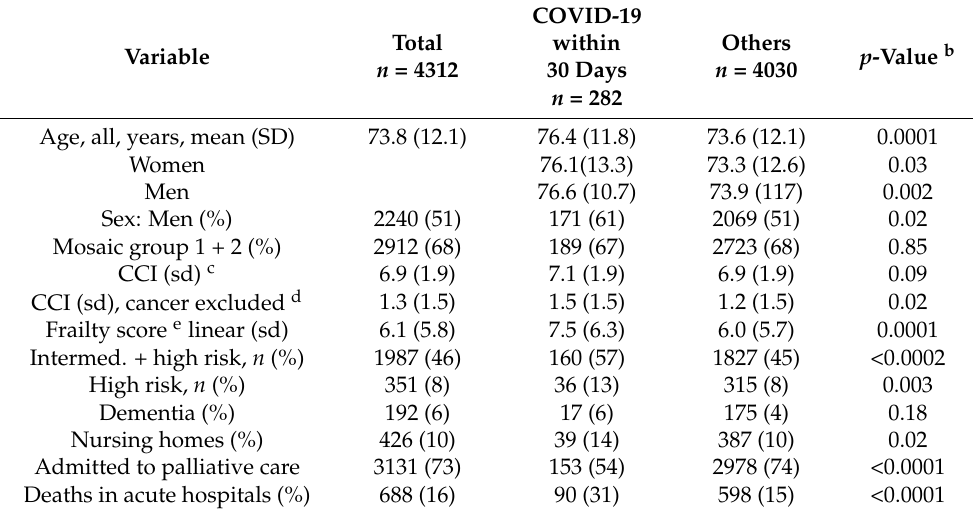
Table 1. Characteristics of patients aged >18 years who died with advanced cancer a ( n = 4312) in Stockholm County from 1 March 2020 to 30 June